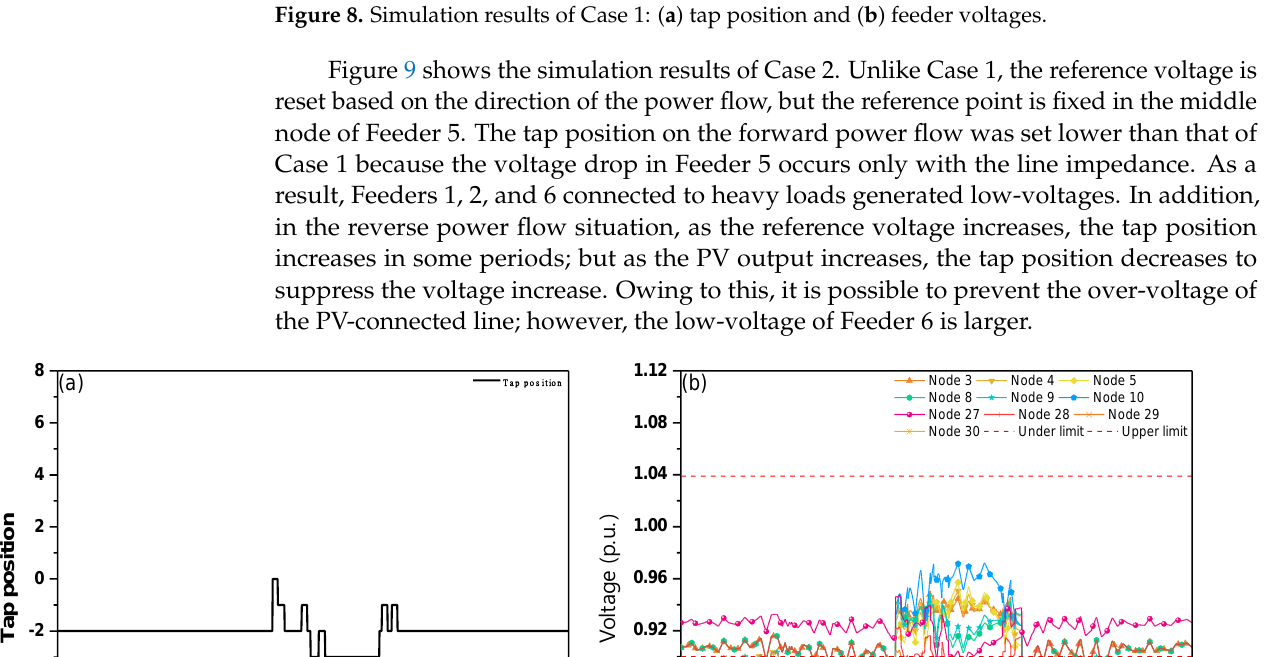
Figure 8. Simulation results of Case 1: ( a ) tap position and ( b ) feeder voltages.